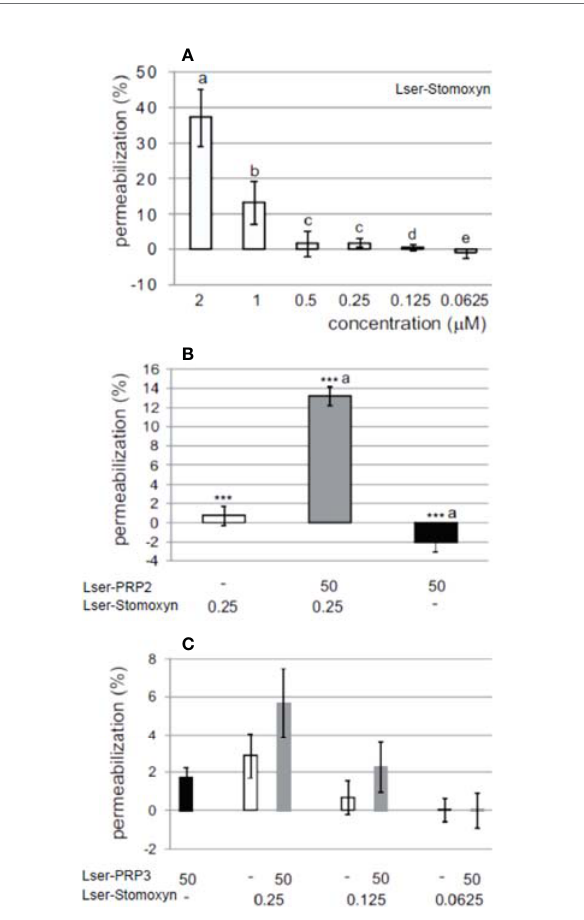
FIGURE 3 | Membrane permeabilization assay. Escherichia coli were incubated alone or in the presence of Lser-stomoxyn (A) and/or Lser-PRP2 (B) and/or Lser-PRP3 (C) for 45 min at 37°C. Membrane permeabilization was evaluated by measuring b -galactosidase activity. Live bacteria incubated alone and bacteria killed by exposure to 5 µM synthetic cecropin B served as the control samples. The permeabilization level of the dead bacteria was set to 100%. Data are means ± standard deviations (n=6). (A) Statistically signi fi cant differences are indicated using different letters (p ≤ 0.001; one-way ANOVA). (B) The same letters indicate statistically signi fi cant differences between the peptide-treated experimental groups (Mann-Whitney U test). The asterisks indicate statistically signi fi cant differences between peptide-treated bacteria and controls (***p ≤